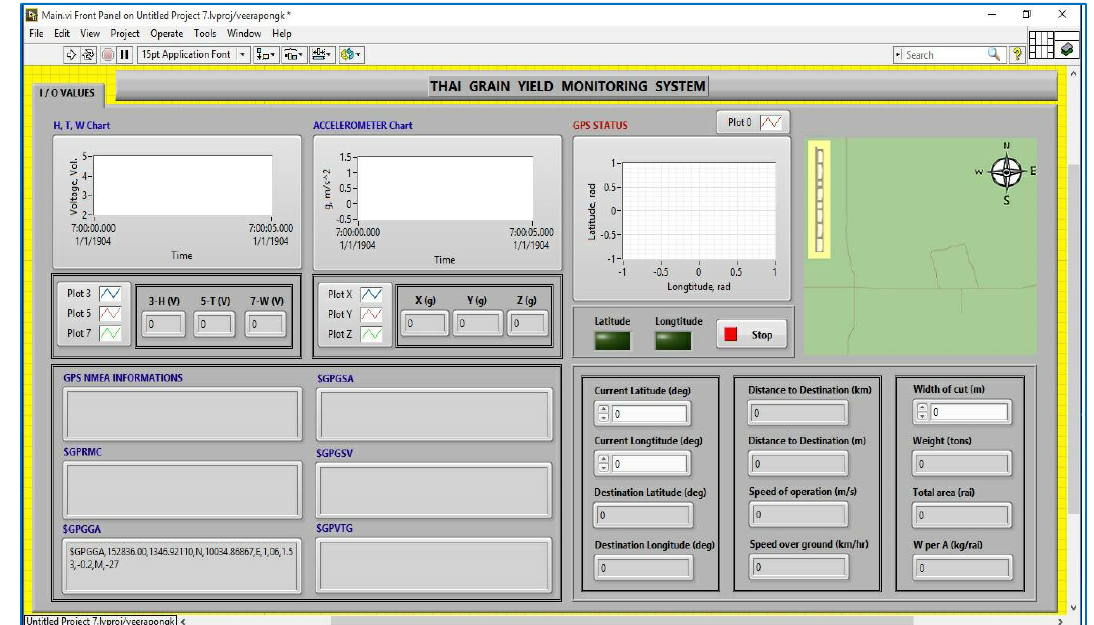
Figure 3. Yield monitoring display developed in Microsoft ® Visual Basic ® .